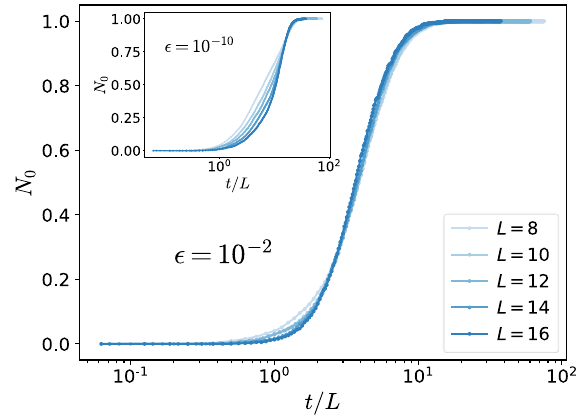
FIG. 14. Dynamics of charge sharpening in the statistical model. Fraction of trajectories with δ Q 2 < ϵ with ϵ ¼ 10 − 2 at p ¼ 0 . 24 , inside the fuzzy phase. Inset: different threshold ϵ ¼ 10 − 10 , showing a similar scaling of the charge sharpening over a timescale t ∼ L .